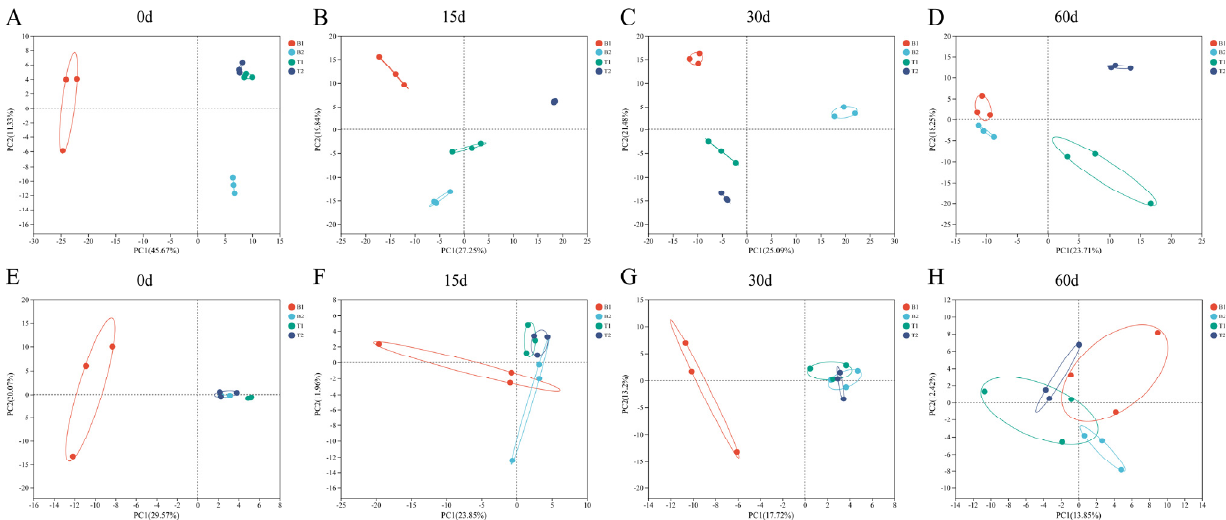
Figure 4. Principal component analysis (PCA) of bacterial and fungi community on the genus level during fermentation. ( A − D ): PCA of the bacterial community on 0 d, 15 d, 30 d, and 60 d, respec- tively; ( E − H ): PCA of fungi community on 0 d, 15 d, 30 d, and 60 d, respectively. B1, V mushroom residue: V sheep manure = 5:1, with CMA inoculation; B2, V mushroom residue: V sheep manure = 5:1, without inoculation; T1, V mushroom residue: V sheep manure = 9:1, with CMA inoculation; T2, V mushroom residue: V sheep manure = 9:1, without inoculation.